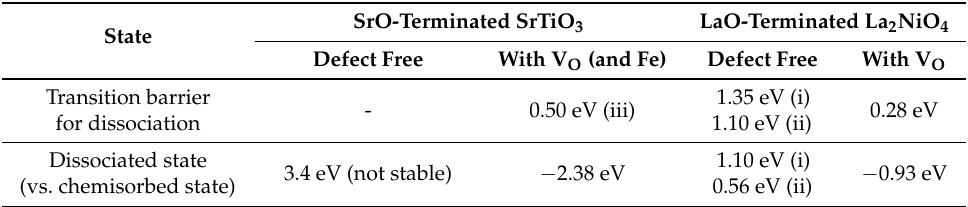
Calculated Energy of Oxygen Dissociation on Simulated Surfaces (lowest energy configurations) vs. the Chemisorbed State, from [106,107] by Akbay et al. and Staykov et al.